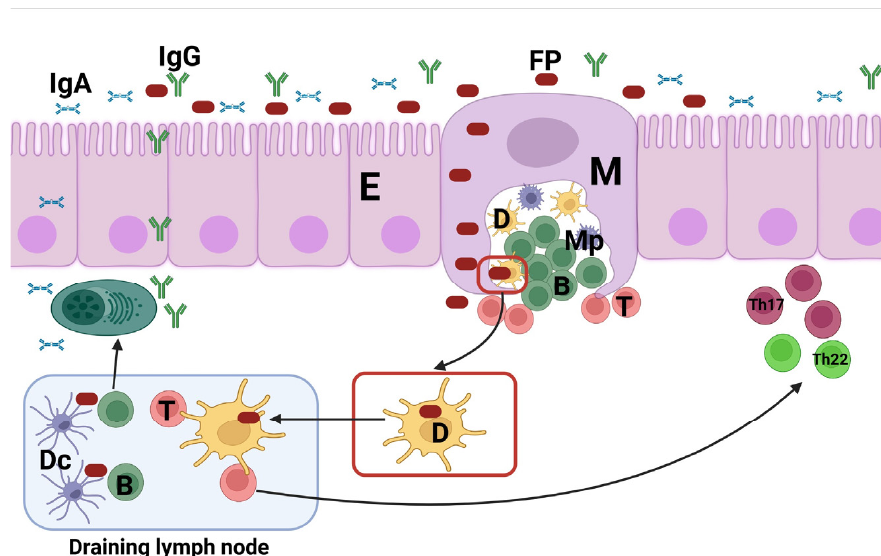
Figure 4. Immune response elicited by hFcgRI-targeted vaccines. Following intranasal immunization, the fusion proteins (FPs) containing the APC-targeting component α -hCD64 and the antigen crosses through M cells (M) at the nasal-associated lymphoid tissues (NALT). Following transcytosis, the FPs are taken up by antigen-presenting cells including DCs (D) and macrophages (Mp). APCs can either present the antigens to the T cells (T) at the NALT or at the draining lymph nodes, ensuing adaptive immune response including the generation of antigen-speci fi c IgG, IgA, and Th17 and Th22 responses. The IgG and IgA at the mucosa are secreted (Transcytosis: arrow across the epithelium) to the mucosa thereby preventing the invasion of the cognate pathogen. E: Epithelial cells, Dc: follicular dendritic cells.